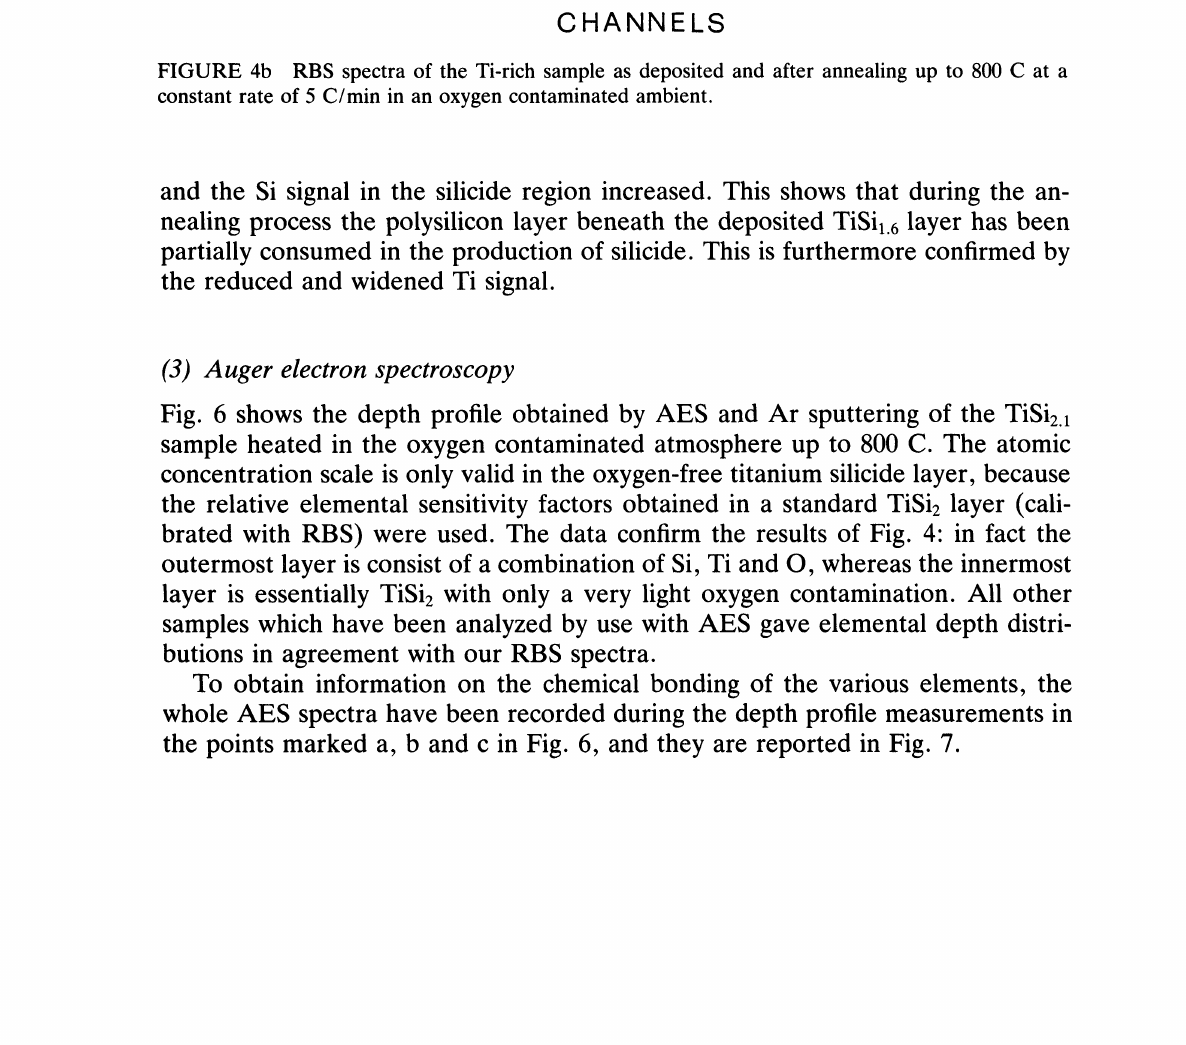
FIGURE 4b RBS spectra of the Ti-rich sample as deposited and after annealing up to 800 C at a constant rate of 5 C/min in an oxygen contaminated